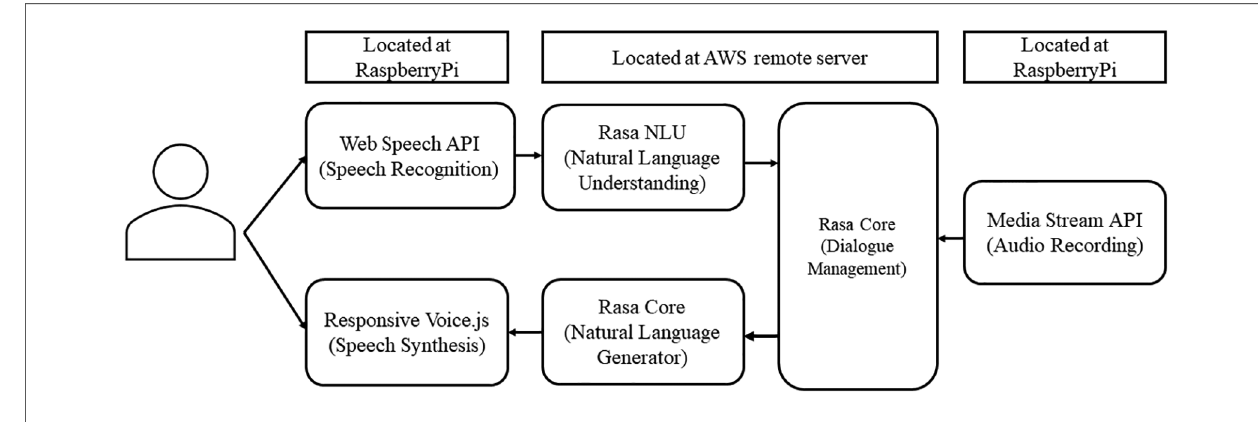
FIGURE 1 Conversational agent system architecture.